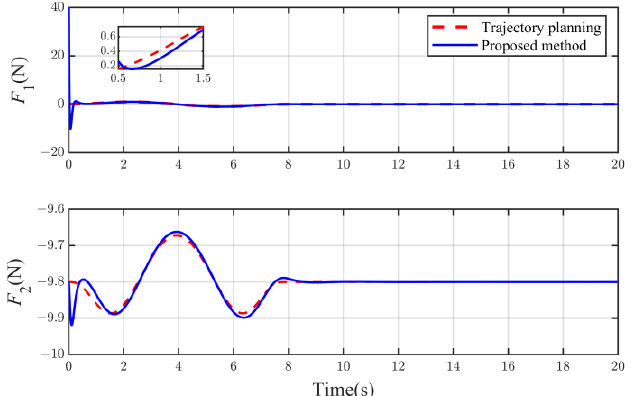
Figure 7. Control input with initial deviation.